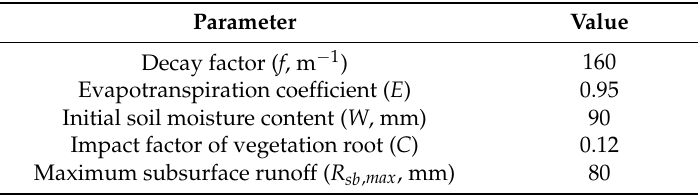
Table 3. Main parameters in the hydrological model TOPX.